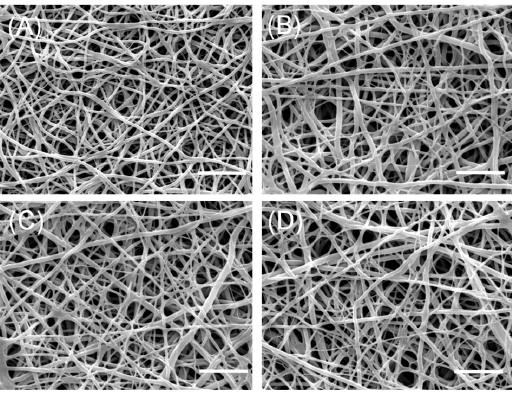
Figure 1. Representative SEM images of pristine chitosan nanofibers (CNs) ( A ); neutralized CNs ( B ); CNs with passively-adsorbed substance-P (SP) (P-CNs) ( C ); and CNs with covalently-immobilized SP (S-CNs) ( D ). Scale bar: 5 μ m.